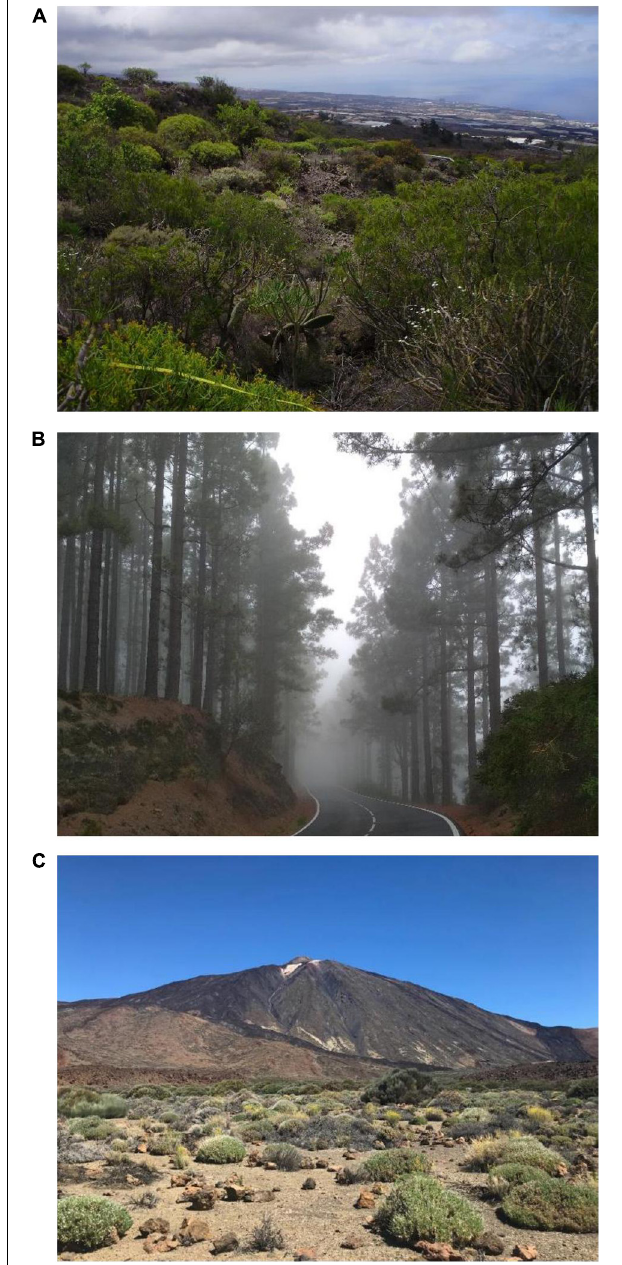
FIGURE 1 | The elevational gradient sampled in Tenerife starts with (A) coastal vegetation and thermo-sclerophyllous scrub, followed by (B) forests of Canary Island pine ( Pinus canariensis C. Sm.), and ending at the high elevation plateau of Las Cañadas with (C) high mountain scrub.